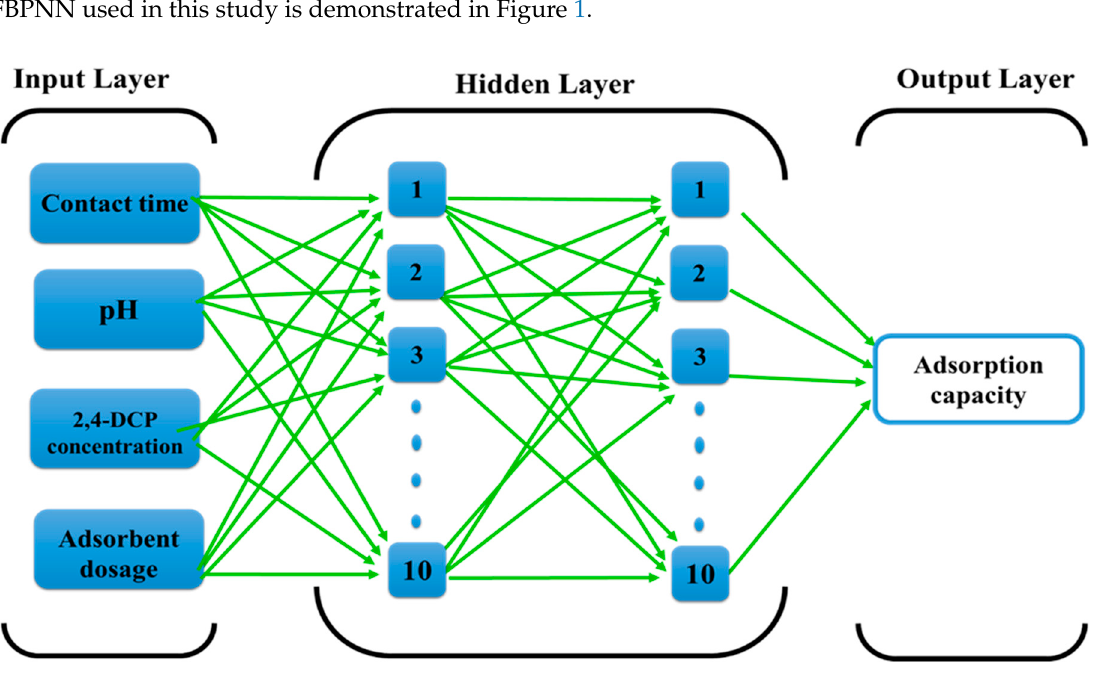
Figure 1. The proposed feed-forward back-propagation neural network structure.